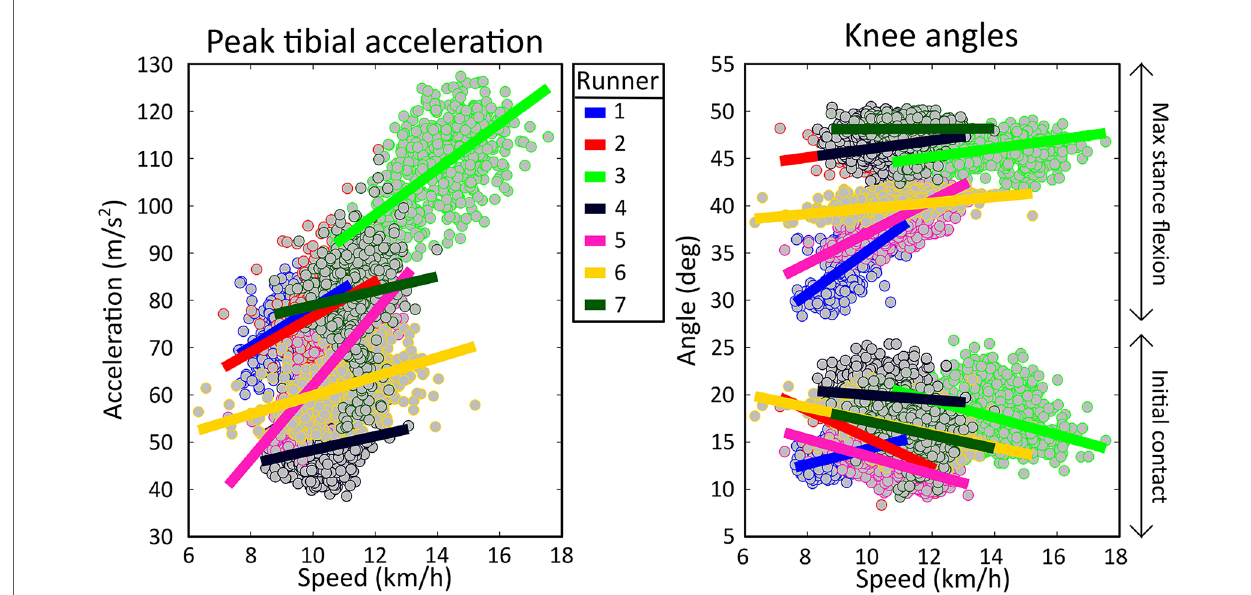
FIGURE 4 Scatterplot of individual peak tibial acceleration and knee angle values as a function of speed. Each dot represents the median value over a segment of 25 strides during the marathon. Subject-speci fi c linear regressions are shown as solid lines.